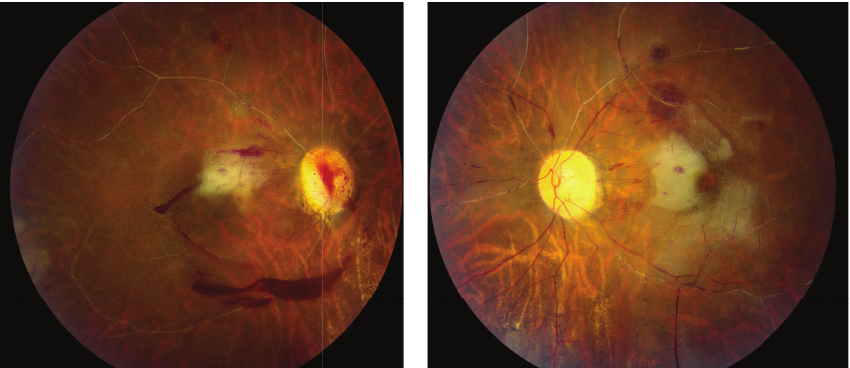
Figure 1: Color fundus photos of each eye show bilateral retinal arterial “boxcarring,” retinal whitening, intraretinal and preretinal hemorrha- ges, and cherry red spots.